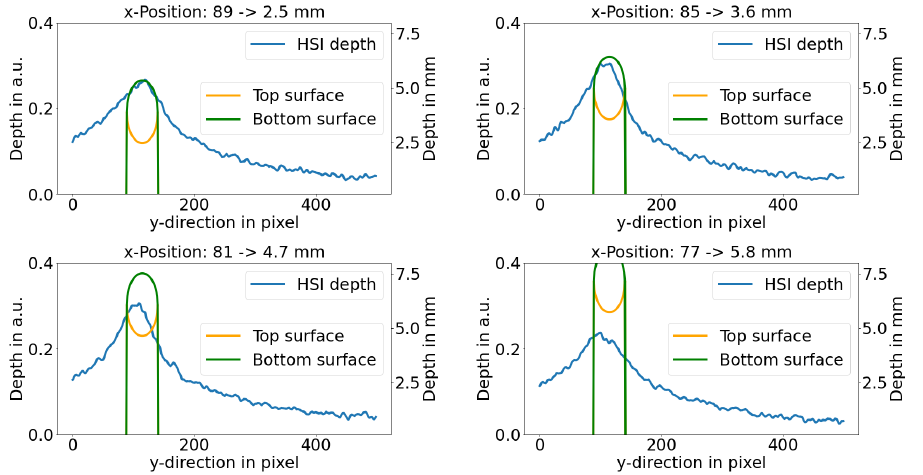
Figure 5. HSI depth parameter perpendicular to the inclusion for different positions along the inclusion and the lower and upper depth of the inclusion. The left y-axis shows the depth parameter and the right y-axis the results from the real depth. The green and orange graphs represent the real depth, measured by an OCT and a caliper.